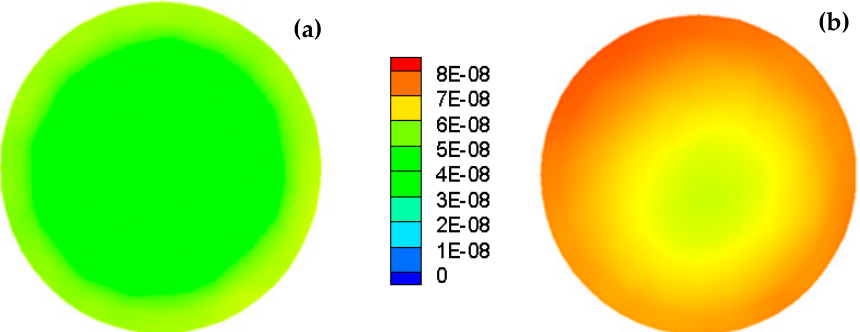
Figure 6. Particle size distribution comparisons at the system outlet where ( a ) contours of the Sauter mean diameter ( D 3,2 ) (m) obtained using surface growth only model for crystallization and ( b ) using combined aggregation and surface growth model.